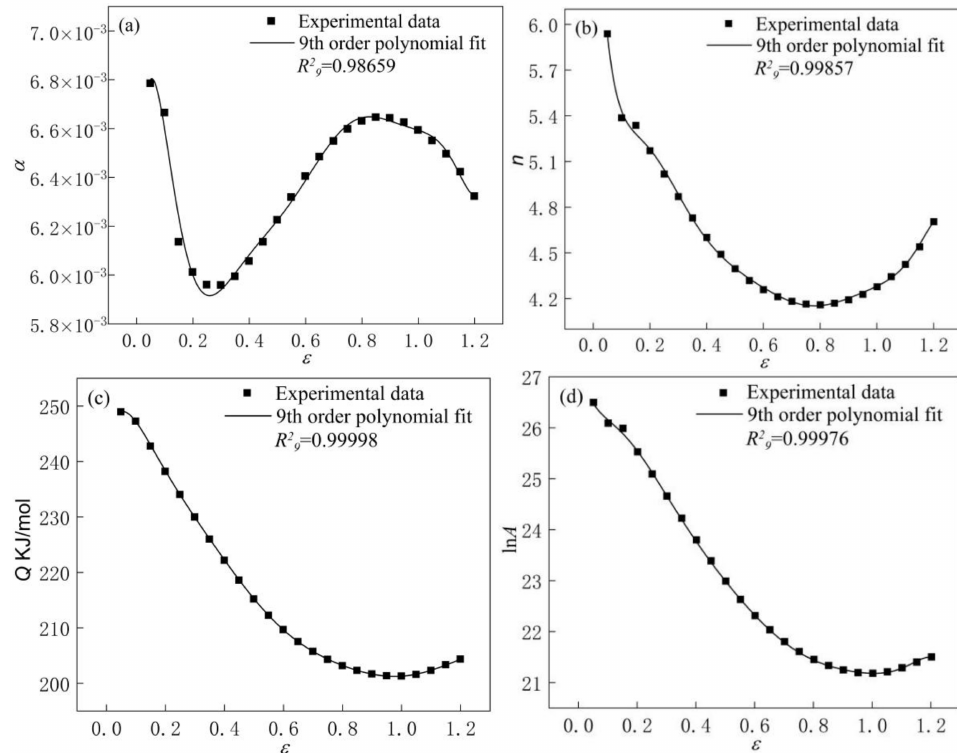
Figure 4. Variation of ( a ) α , ( b ) n , ( c ) Q, and ( d ) ln A with true strain ε